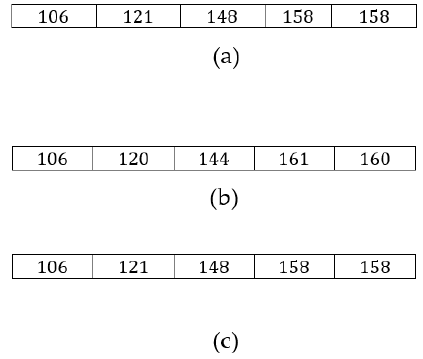
Figure 4. An example of quad-pixel reversible data embedding: ( a ) before embedding; ( b ) after embedding; ( c ) after extraction.